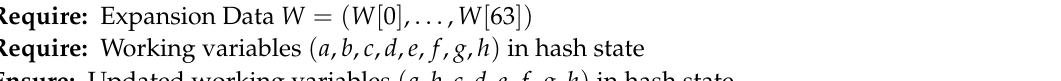
Algorithm 2 SHA-256 Message